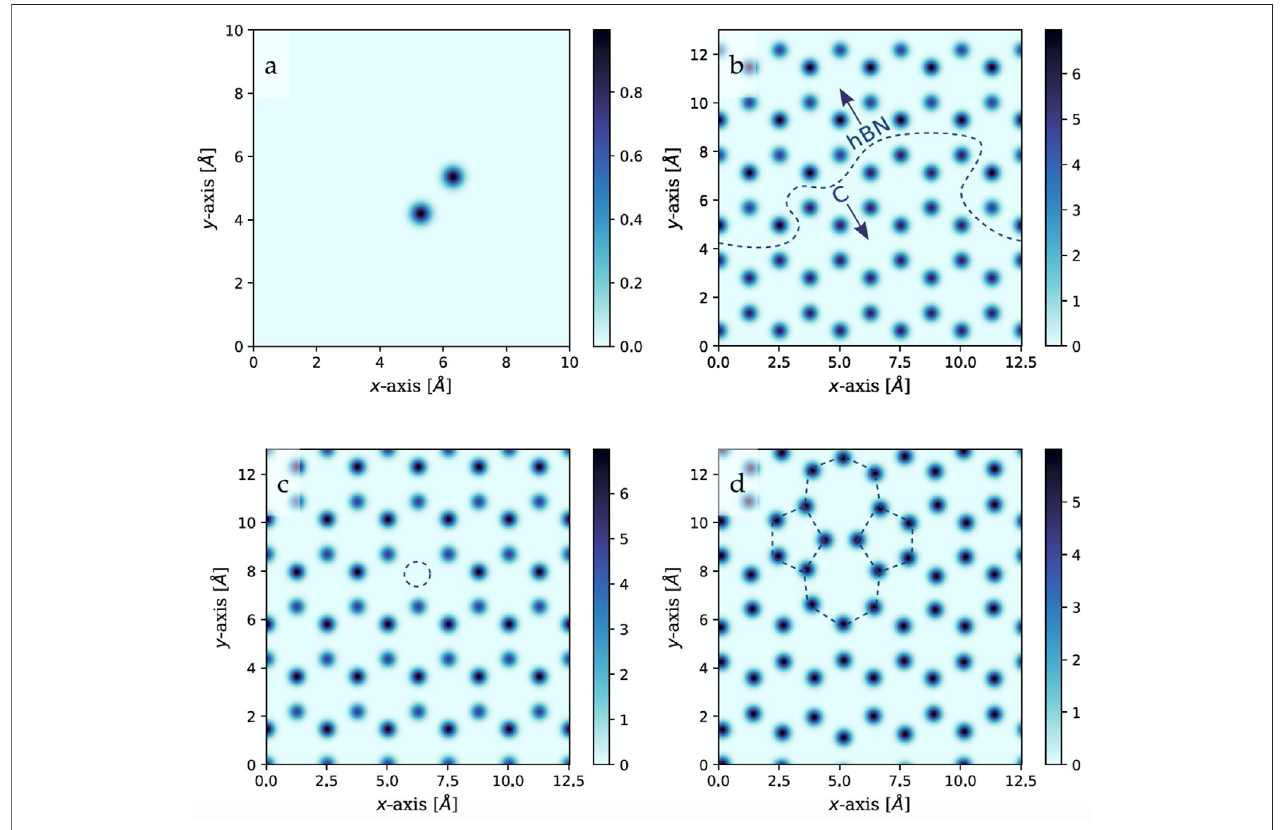
FIGURE3| Simpli fi ed2Drepresentationof3Dvoxelizedimagerepresentationsofmaterials: (A) Representsadimer, (B) agraphene-hBNheterostructure, (C) hBN with a N vacancy, and (D) graphene with a Stone-Wales defect. Reprinted with permission from Ryczko et al. (2017).